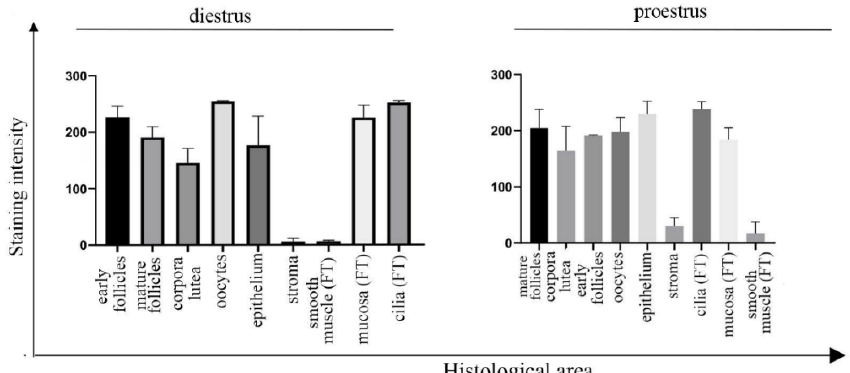
Figure 2. Quantification of UNC-45A expression levels in mouse ovaries and fallopian tubes (FTs) during diestrus and proestrus following IHC staining. Quantification of UNC-45A staining intensity in the single components of the ovary and fallopian tube. Quantification is expressed as mean pixel intensity, during diestrus ( left ) and proestrus ( right ).